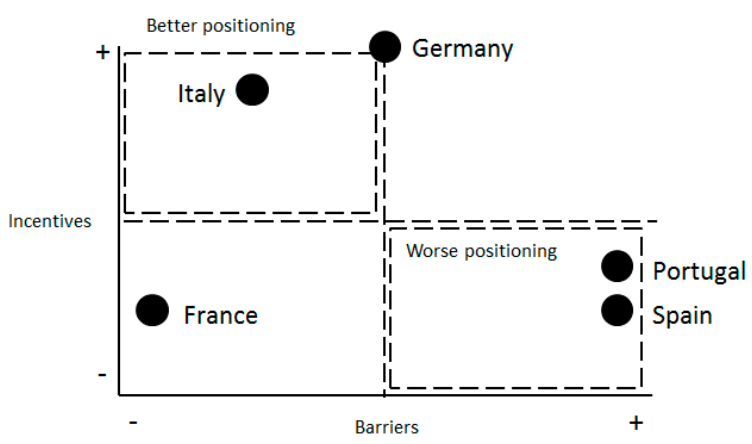
Figure 2. Current positioning for the development of self-consumption systems (own elaboration).